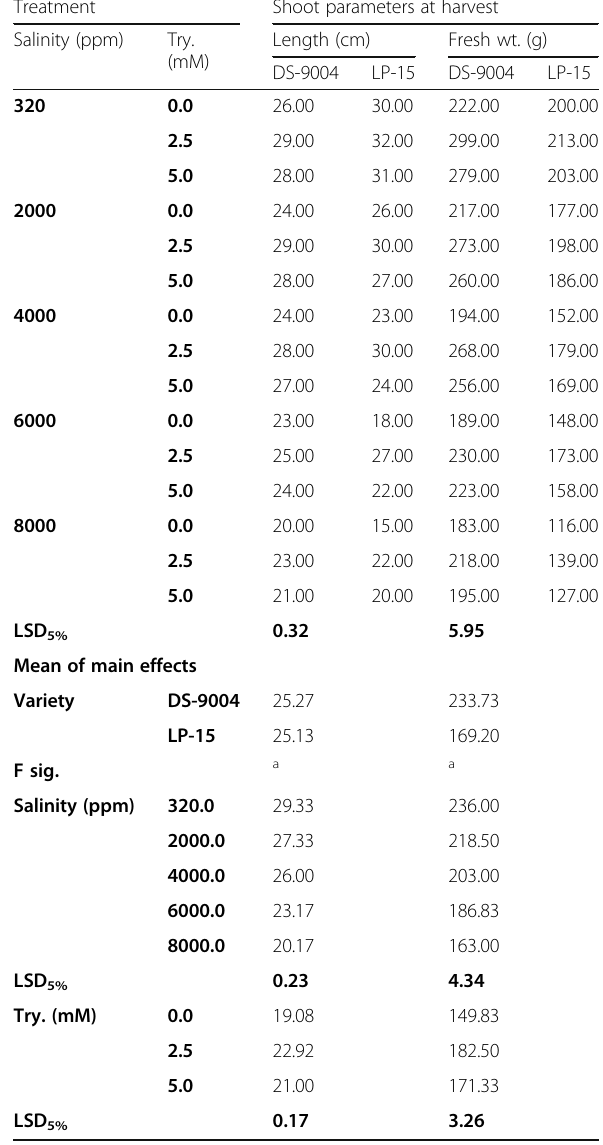
tryptophan and irrigated with different salinity levels on shoot parameters at harvest (180 days after sowing) Treatment Shoot parameters at harvest Salinity